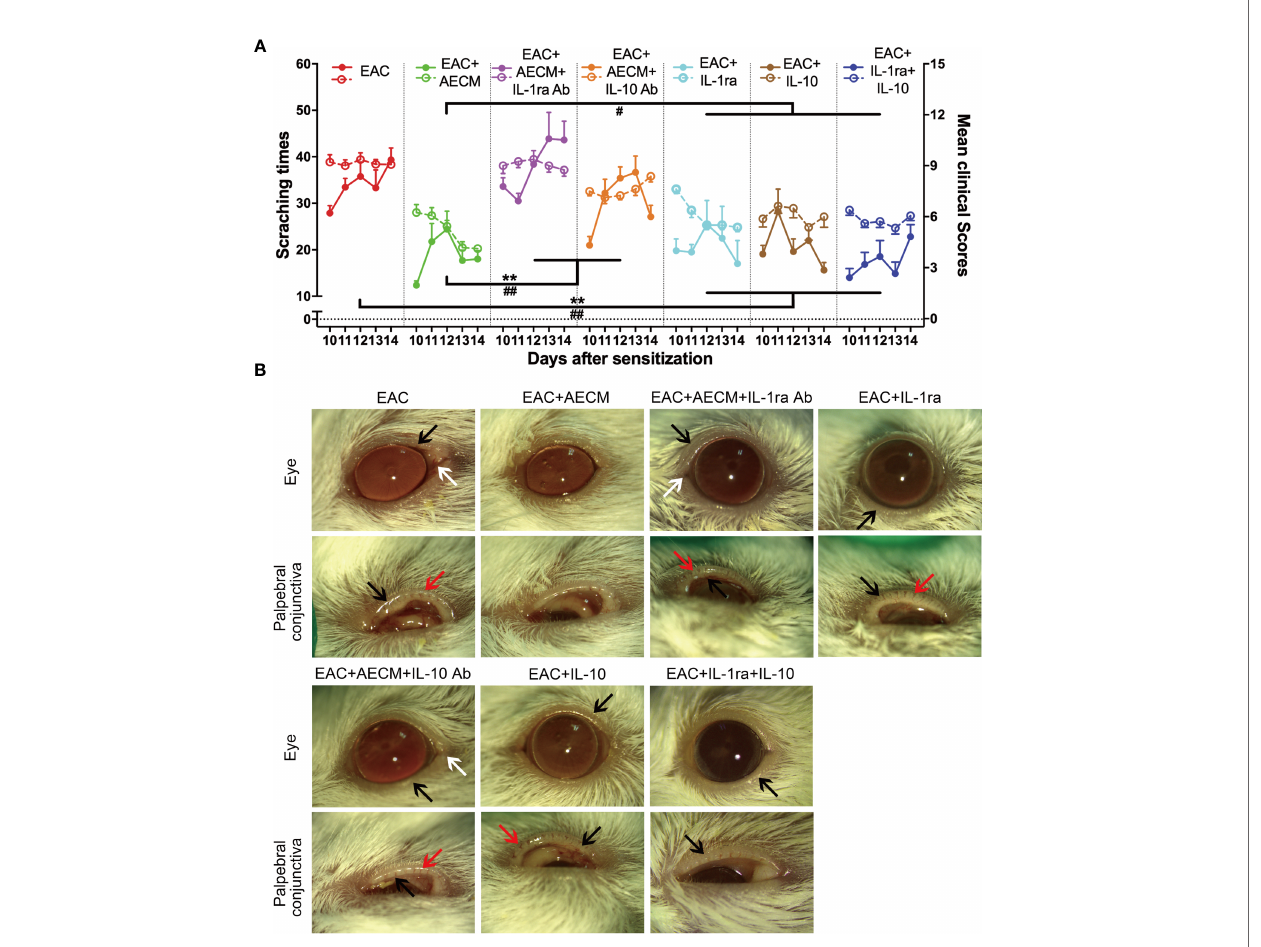
FIGURE 7 | Anti-in fl ammatory factors IL-1ra and IL-10 are necessary for AECM-mediated amelioration on AC symptoms of EAC mice. (A) The times of scratching response (left Y axis, solid points) and clinical scores (right Y axis, hollow points) of the severity of AC symptoms of EAC mice in different groups were evaluated at the indicated time points after challenge with SRW solution. Solid points represent the times of scratching response. Hollow points represent clinical scores. The results are expressed as mean ± SEM. n = 8. ** P < 0.01 in scratching times. # P < 0.05 and ## P < 0.01 in clinical scores. (B) Representative images of ocular symptoms evaluated by slit lamp microscopy for each group at 24 h after the last challenge. White arrows represent chemosis, red arrows represent conjunctival redness, and black arrows represent eyelid